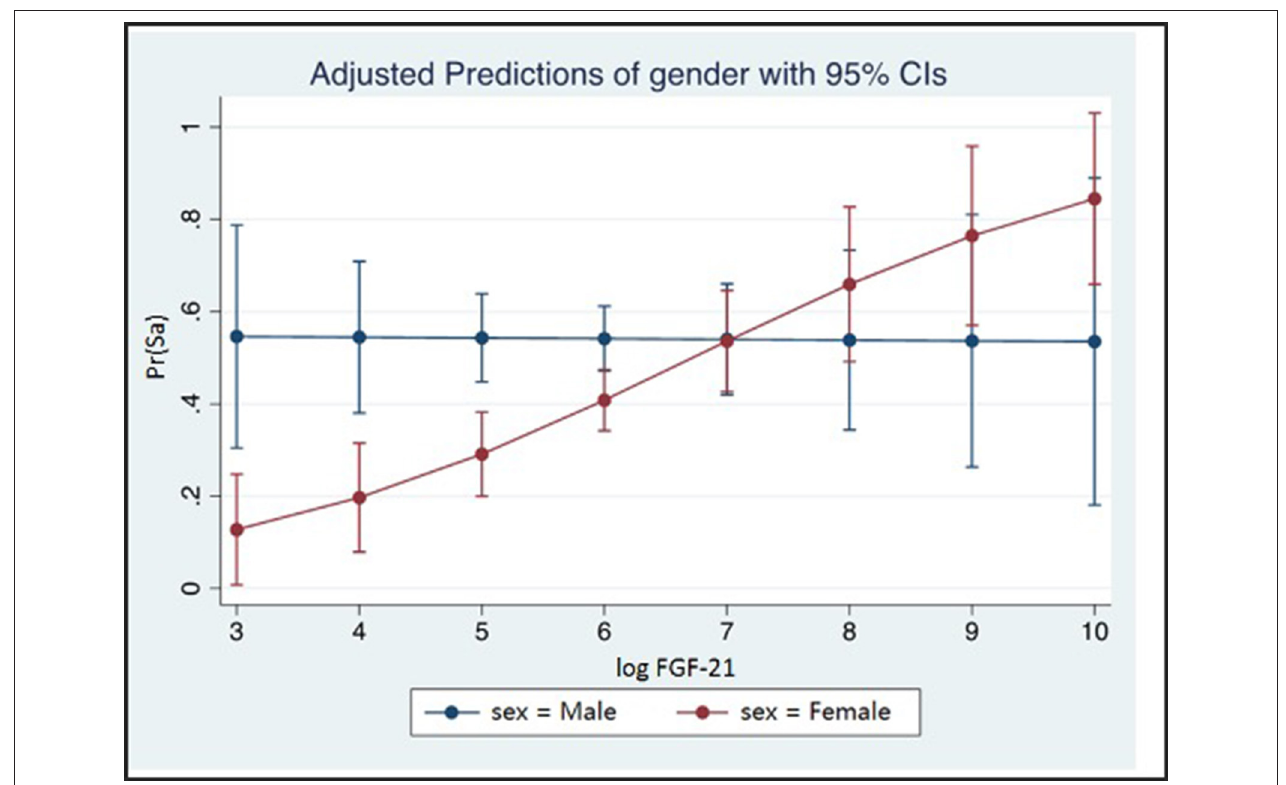
FIGURE 2 | The probability of subclinical atherosclerosis with 95% CI shown at different levels of standardized lnFGF21 in males and females. lnFGF21, standardized natural log fibroblast growth factor 21; SA, subclinical atherosclerosis; interaction test p -value = 0.033.